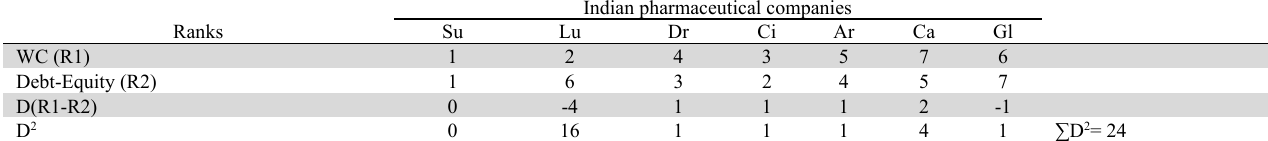
Qualitative relationship between WC and Debt- Equity relationship of Indian Pharmaceutical firms Ranks